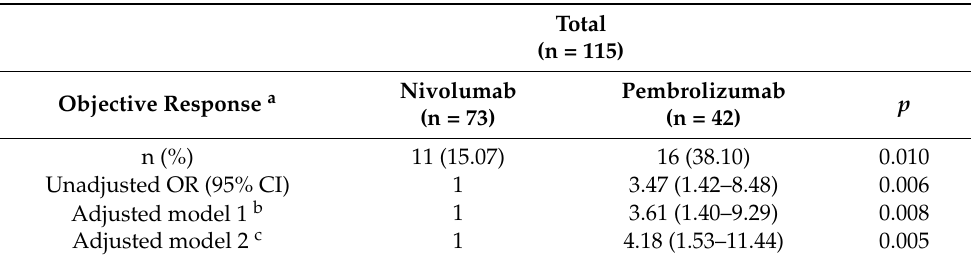
Table 2. Adjusted odds ratio (OR) of achievement of objective response among the patients treated with nivolumab and pembrolizumab.